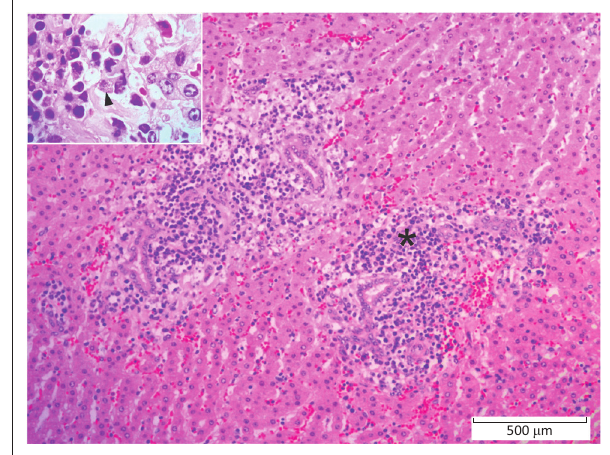
FIGURE 5: Liver, African buffalo. Lymphoplasmacytic portal hepatitis ( * ) because of Theileriosis infection. Inset . Lymphoblastic cell with intracytoplasmic schizonts (arrowhead). Haematoxylin and